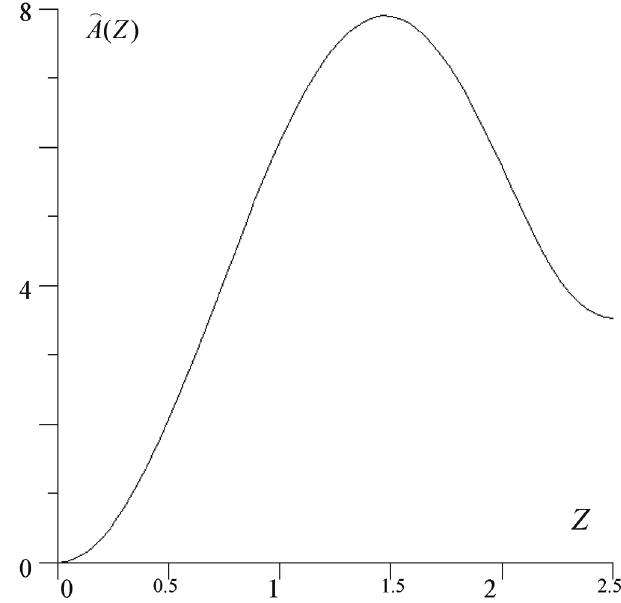
FIG. 5. Longitudinal structure of the propagating wave A(Z) in